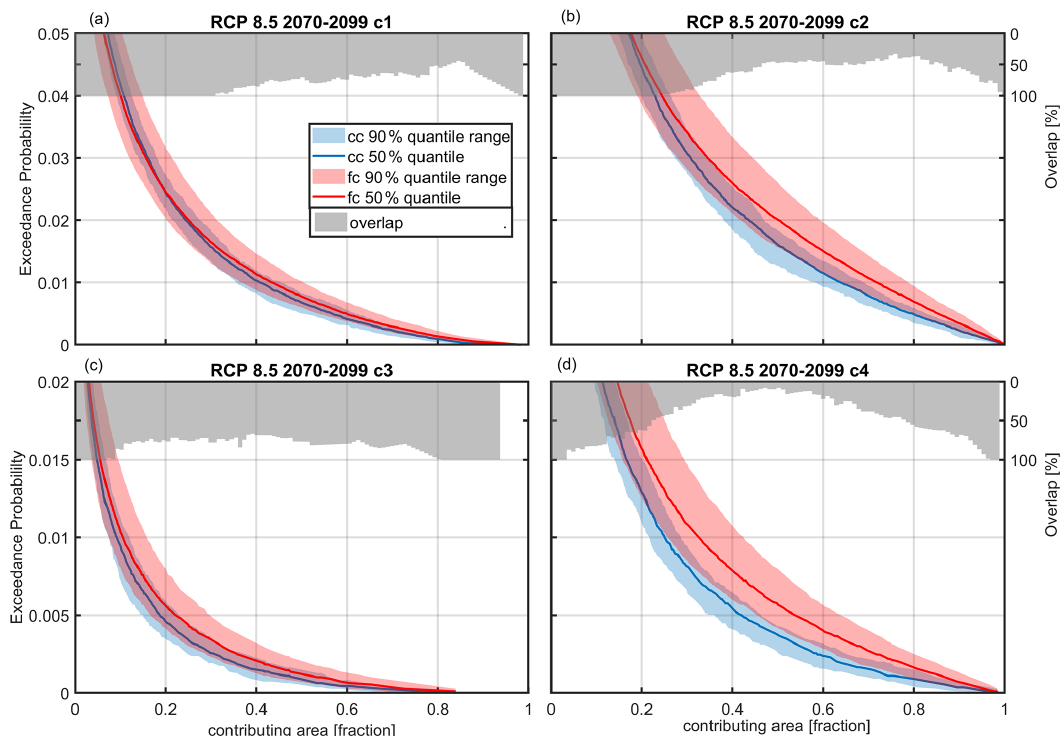
Figure 8. Yearly exceedance probability of contributing area size (as a fraction of the total area) during ROS events for current climate (cc) and RCP 8.5 at the end of the century (fc) for criteria 1 (c1) to 4 (c4). Plotted are the 5th, 50th and 95th percentiles of climate period mean values stemming from 50 (current climate) and 500 climate periods (future climate with 50 realizations of 10 climate models). The overlap indicates how much of the current-climate natural variability is overlaid by the future-climate uncertainty range.